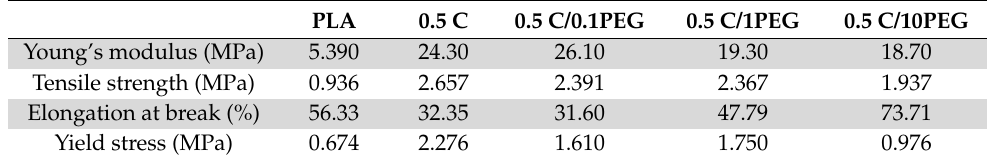
Table 4. Mechanical performance of PEG-containing nanofibers.